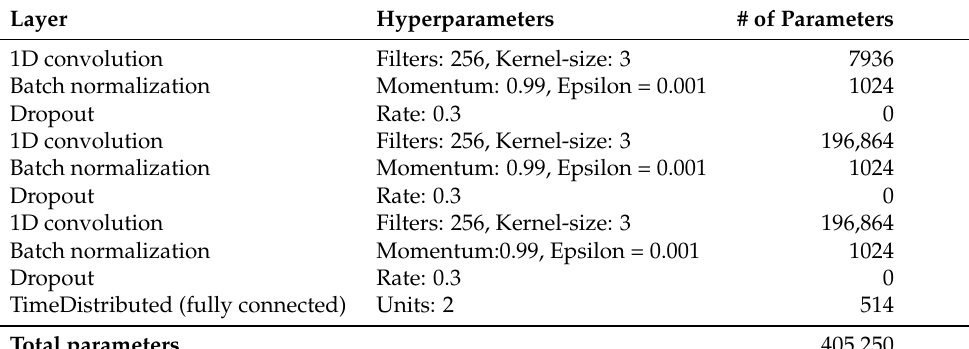
Table 2. Detailed description of the convolutional neural network used in this study.